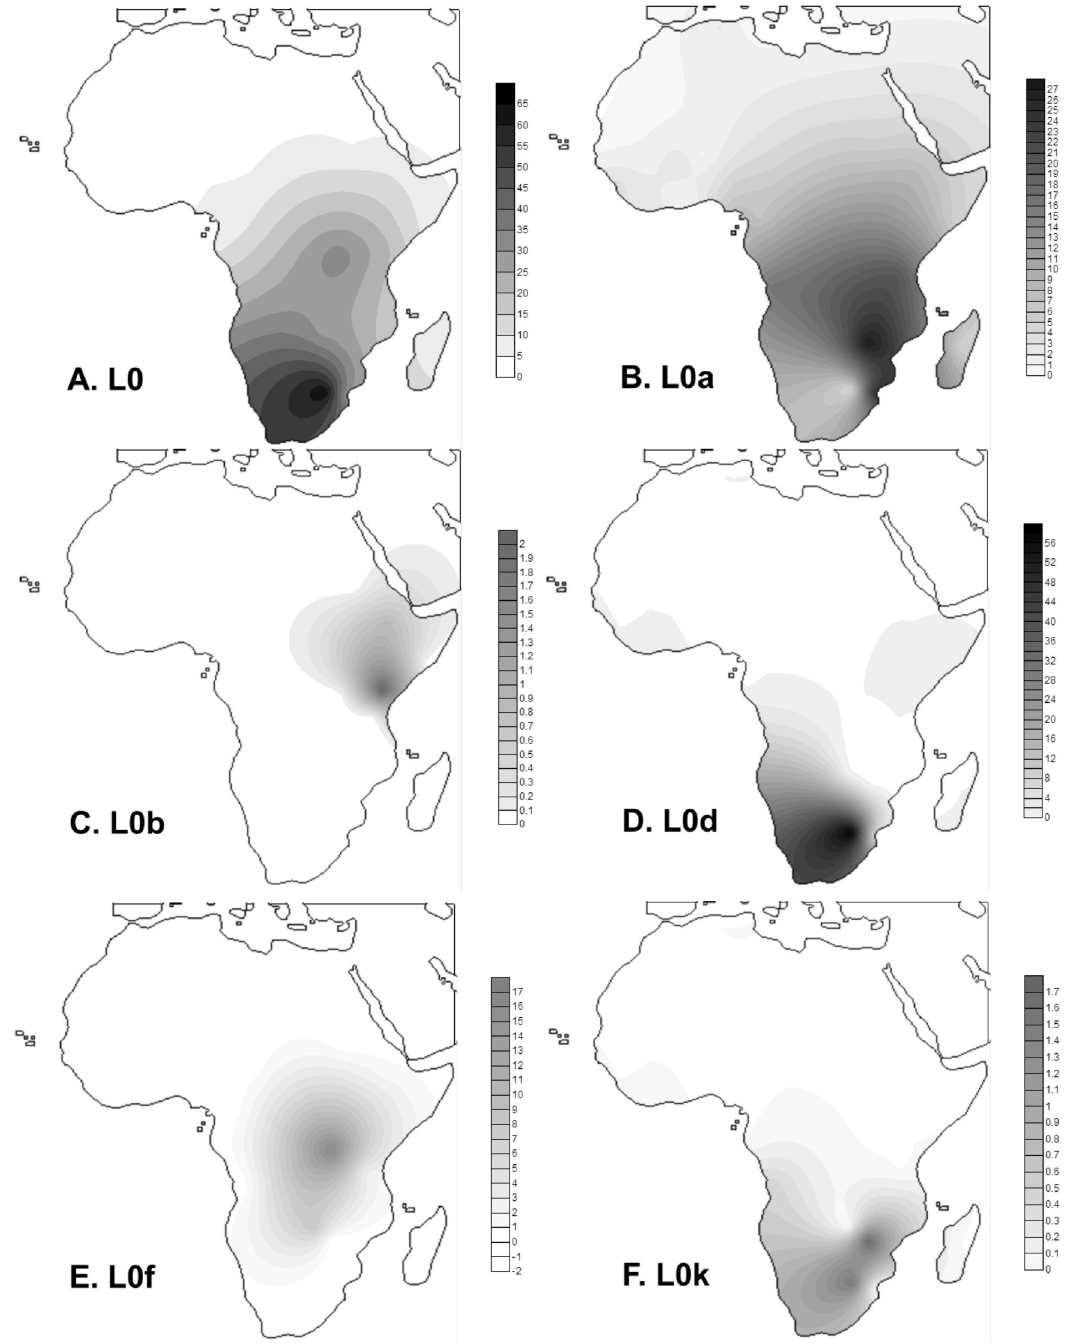
Figure 3. Frequency maps based on HVS-I data for haplogroups L0 (total) (A), L0a (B), L0b (C), L0d (D), L0f (E) and L0k (F). doi: scan and also when considering only the eastern Bantu route (Figure 4 – for clarity only the overall South African scan is shown). This recent peak is generated by the founder ages of the L0a subclades in southern Africa linked to the Bantu